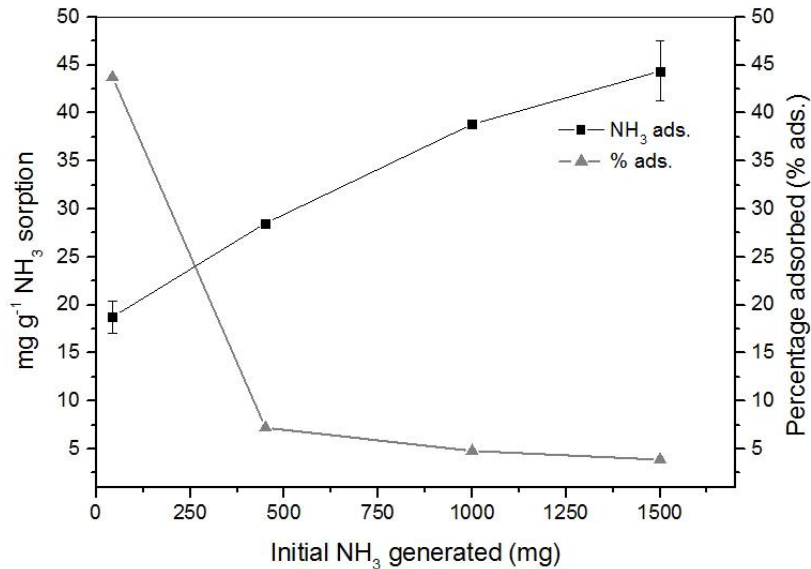
Figure 3. NH 3 sorption capacities for Oak 250 hydrochar at 43, 450, 1000, and 1500 mg NH 3 gas generated according to Equation (2). Error bars represent deviation around the mean. For statistical analysis please refer to supplementary material Table S3.